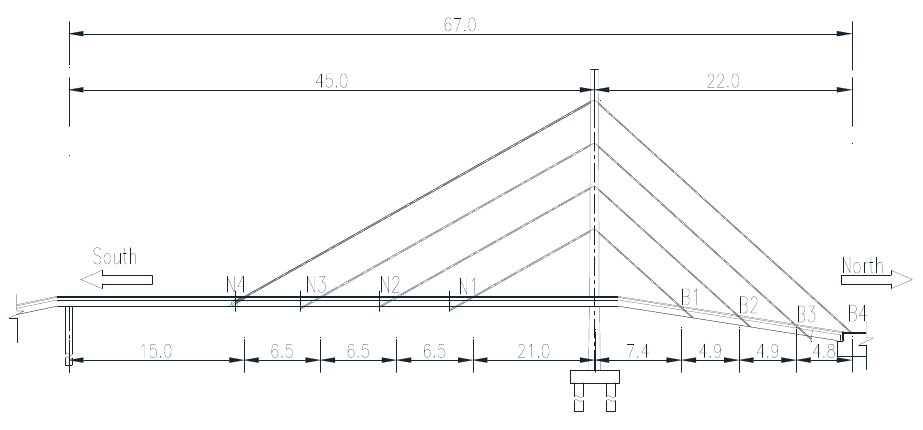
Figure 14. The elevation of pedestrian overpass (unit: m).